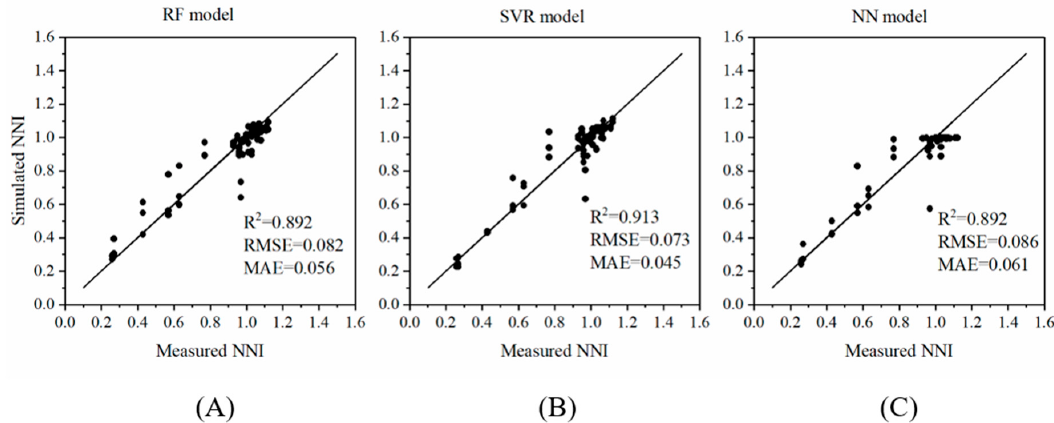
Figure 5. Quantitative relationship between simulated and measured nitrogen nutrition index (NNI) values, represented in the form of scatter plots of the manually measured NNI and the NNI predicted using three models: ( A ) random forest (RF), ( B ) support vector regression (SVR), and ( C ) neural network (NN). The line (y = x) represents the expected prediction. The quantitative relationship between the image-based features and the NNI was evaluated in terms of the coefficient of determination R 2 , root-mean-square error (RMSE), and mean absolute error (MAE) of the models.